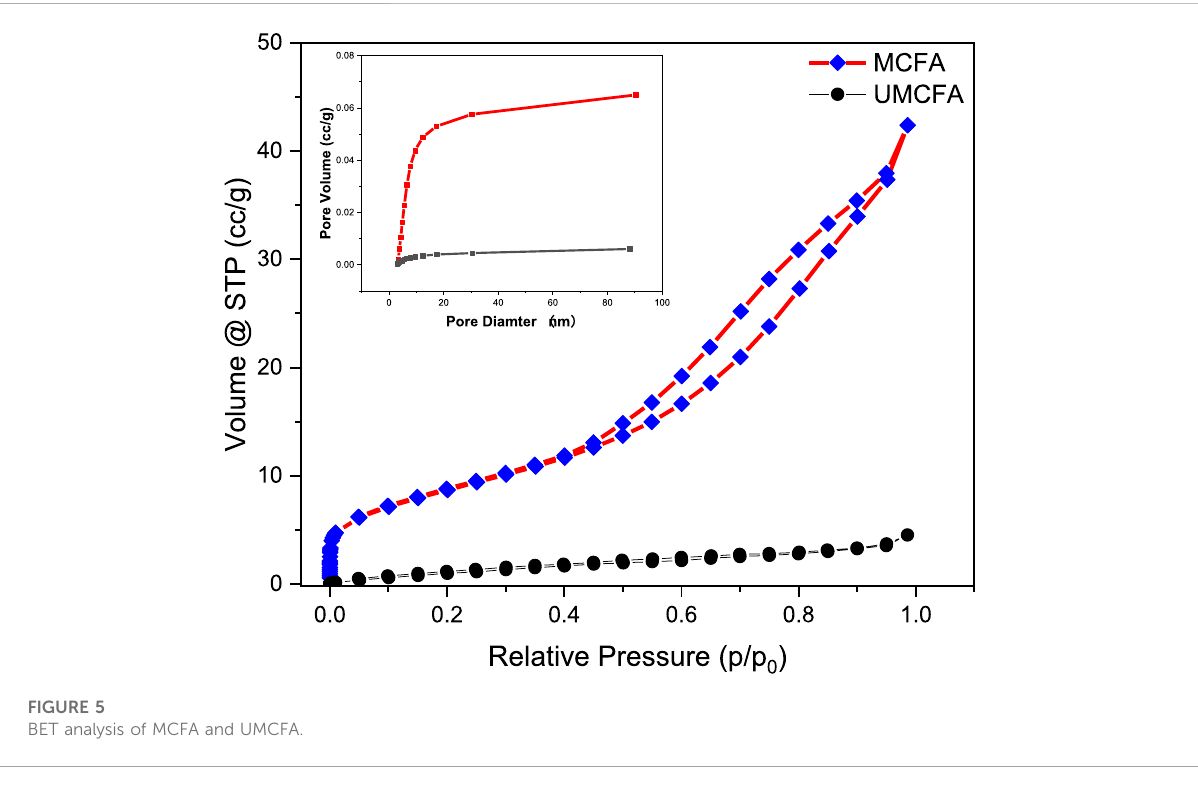
FIGURE 5 BET analysis of MCFA and UMCFA.